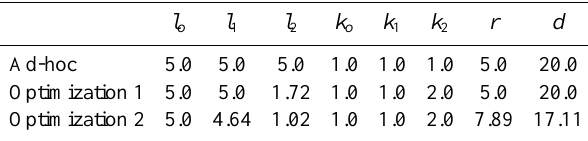
Figure 6. Unbalanced joint forces over the set of grasps in the Fig. 6. UNBALANCED JOINT FORCES OVER THE SET OF optimization pool. GRASPS IN THE OPTIMIZATION POOL. Table 1. RESULTS OF GRIPPER DESIGN OPTIMIZATION. Table 1. Results of gripper design